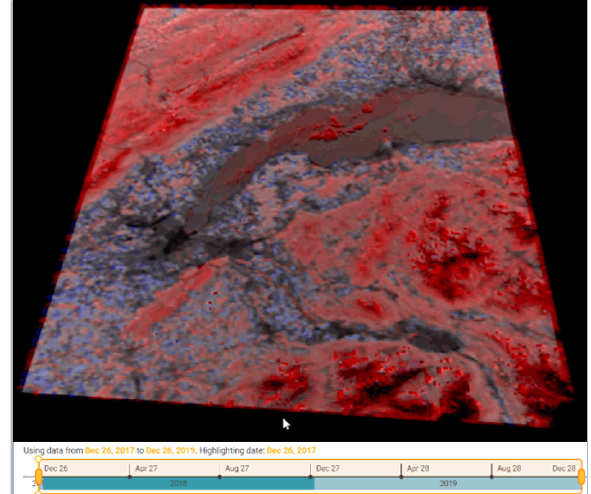
Figure 21. 3D Derived rendering corresponding to the texture generated in Figure